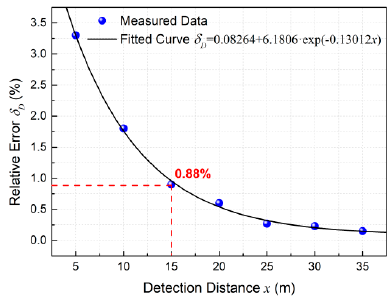
Figure 8. Variation of relative error δ D with the increase of detection distance x .